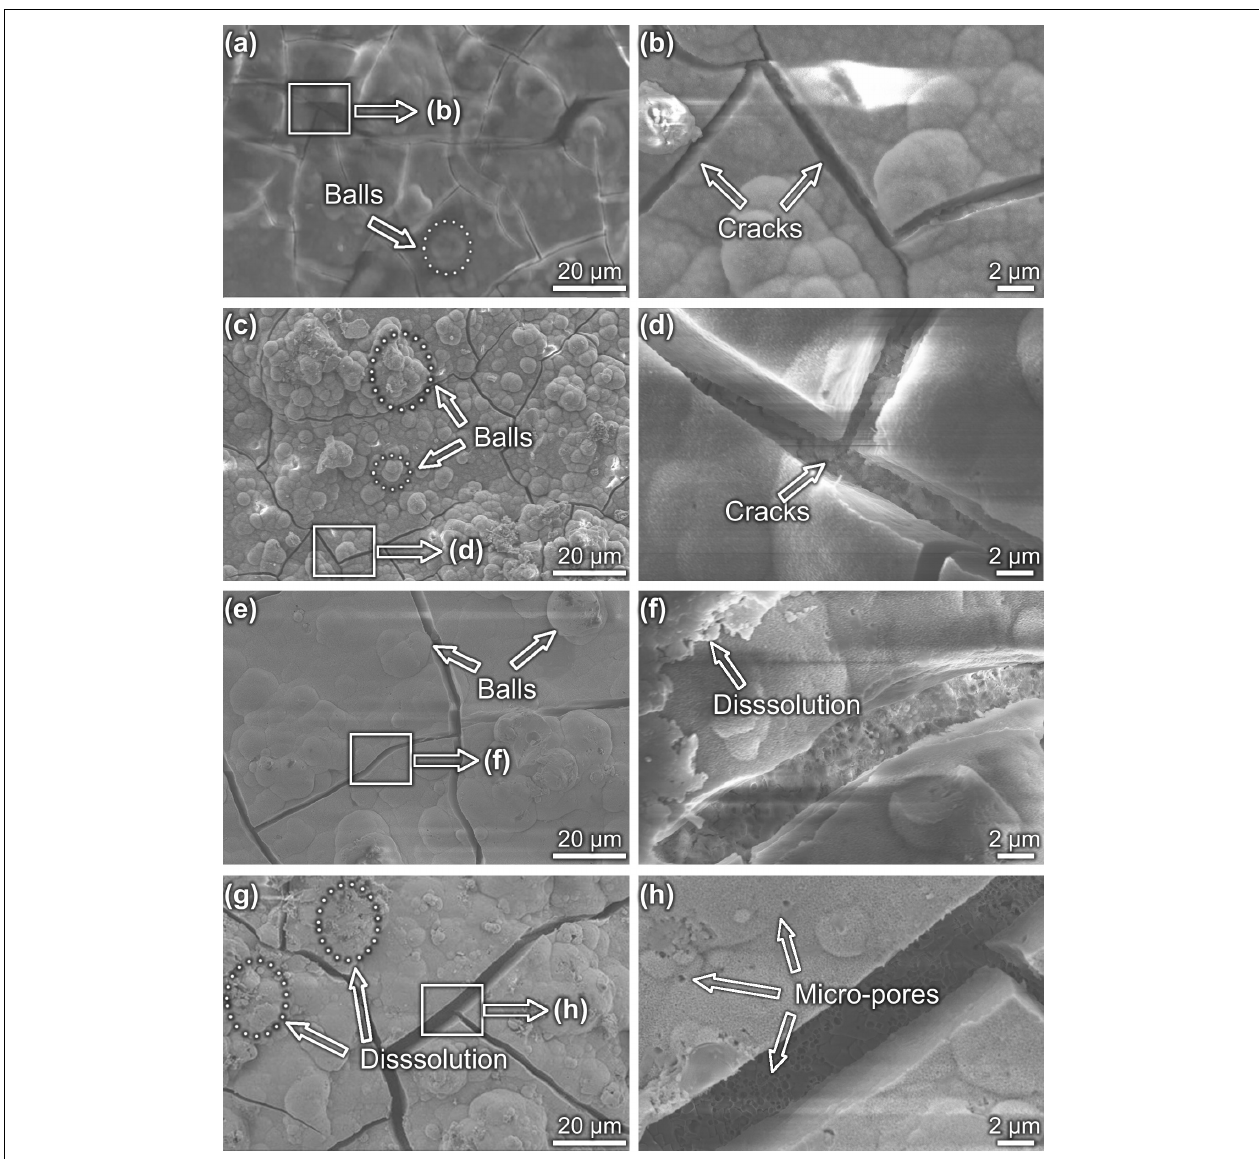
FIGURE 5 | Morphologies of MAO-ED coating samples after different immersion days: (a,b) 5 day, (c,d) 10 day, (e,f) 15 day and (g,h) 20